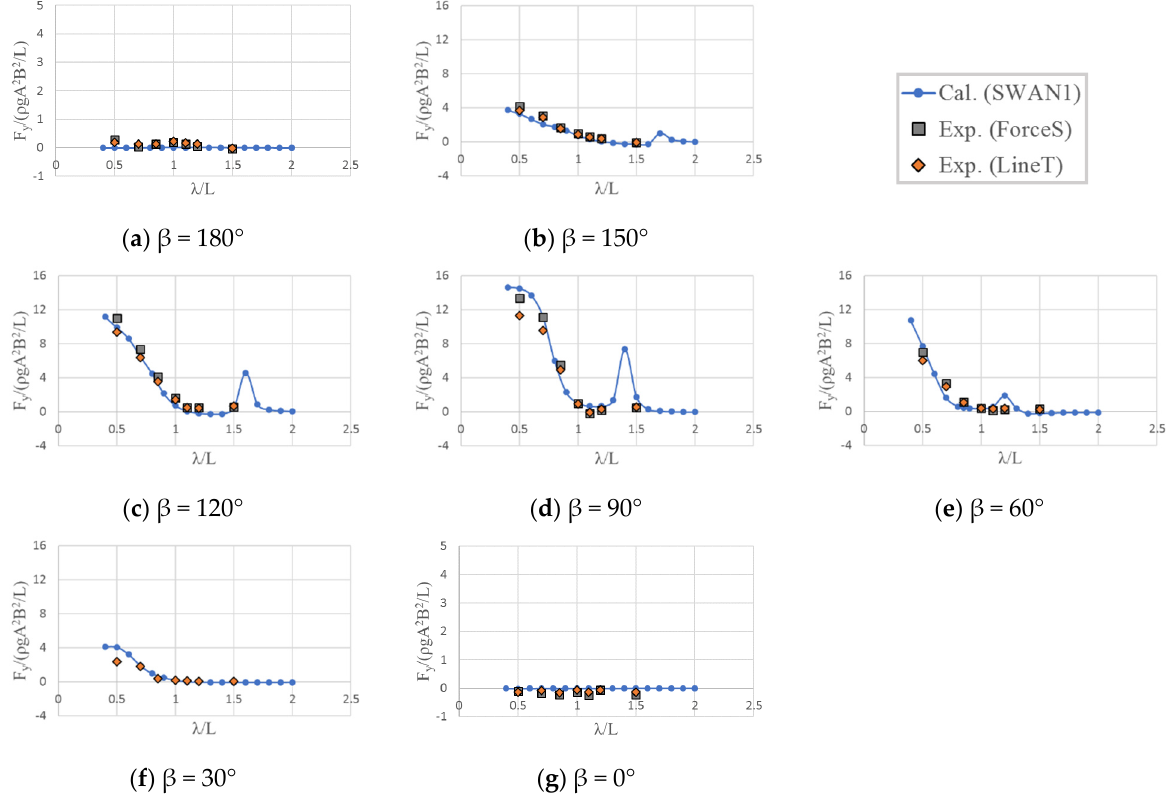
Figure 14. Sway drift force on KVLCC2: V = 6 knots, H/L = 1/50.